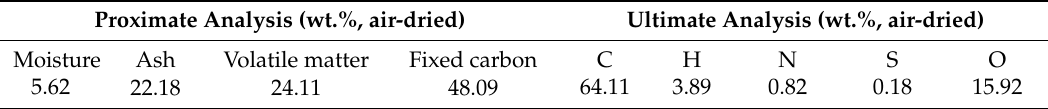
Table 1. Proximate and ultimate analyses of Ordos bituminous coal.